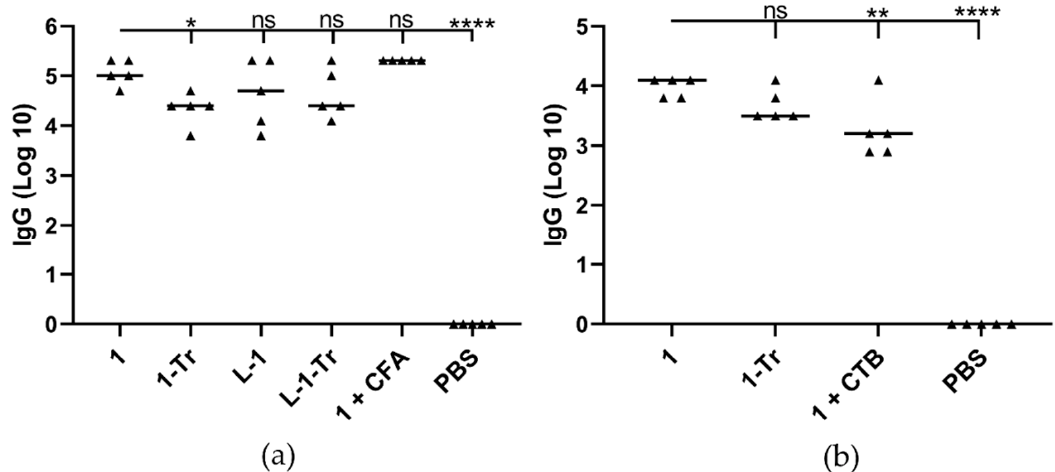
Figure 4. GnRH-specific antibody responses. ( a ) GnRH-specific serum IgG titers following single immunization by subcutaneous injection, and ( b ) GnRH-specific serum IgG titers following single oral immunization. Not significant (ns) p > 0.05, (*) p < 0.05, (**) p < 0.01, (****) p < 0.0001.